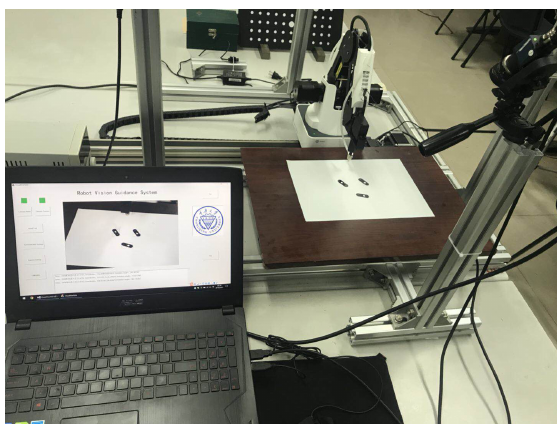
Figure 14. Automatic sorting system with machine vision.